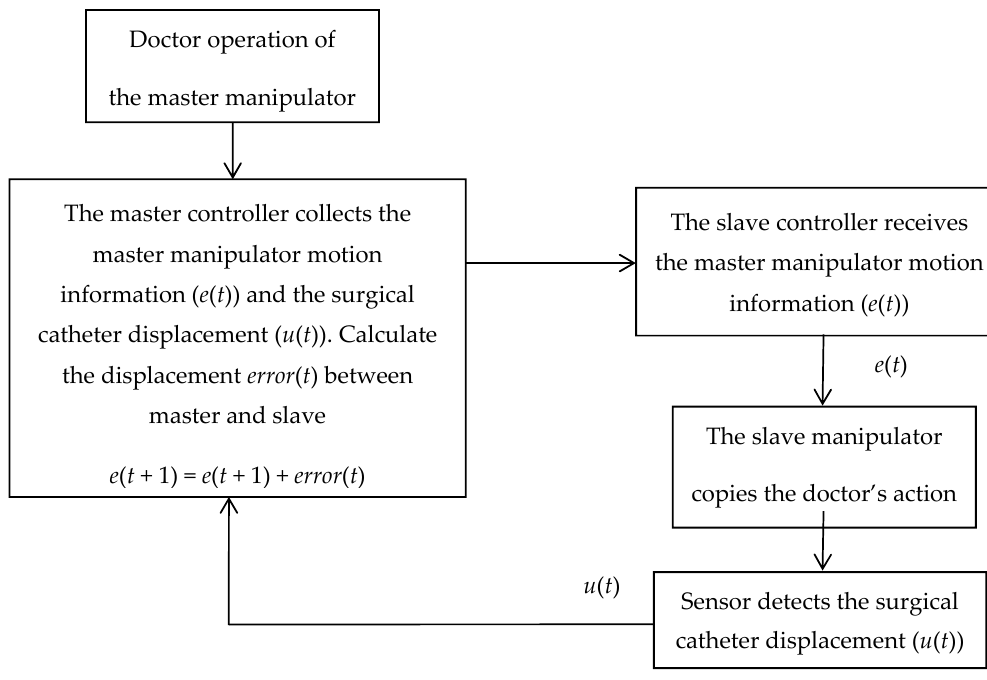
Figure 7. The principle of the surgical catheter displacement error compensation algorithm.